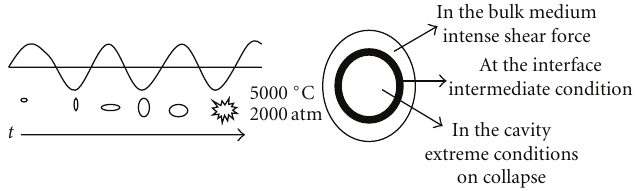
Figure 4: Formation of a cavitation bubble by ultrasound.